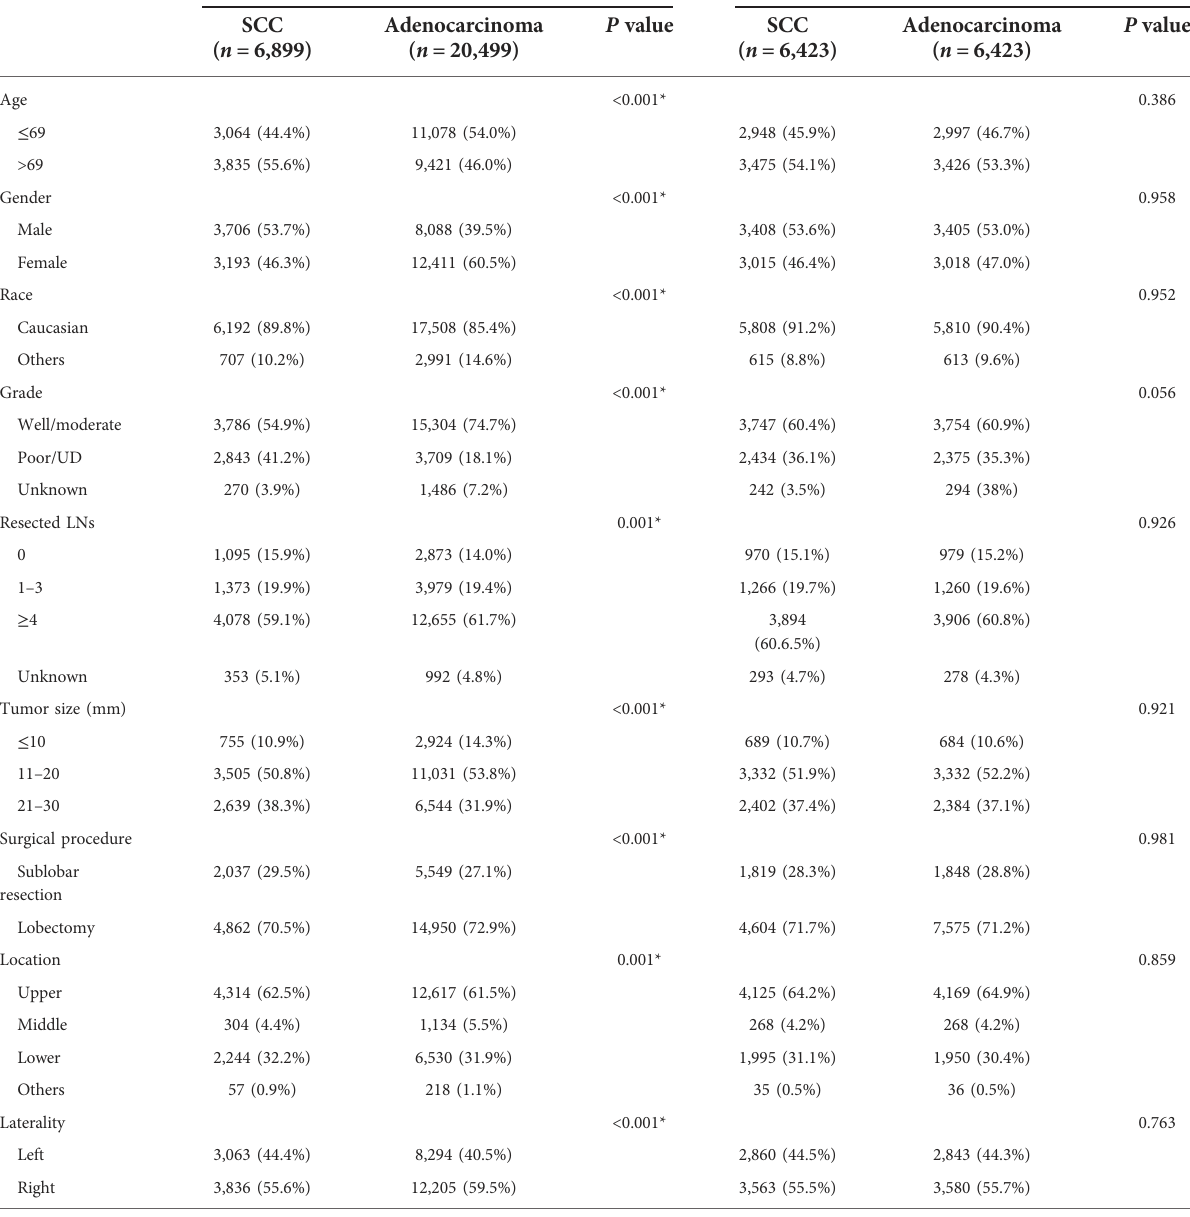
TABLE 1 Baseline characteristics before and after